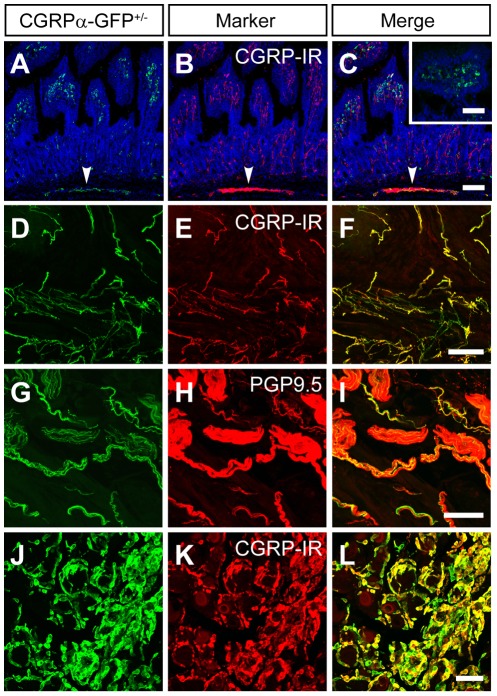
CGRPα-GFP axons and cells in visceral tissues.Sections of (A–C) small intestine, (D–I), bladder and (J–L) thyroid from CGRPα-GFP+/− mice were stained with antibodies to GFP (A, D, G, J) and the indicated markers. Nuclei in (A–C) were labeled with DRAQ5. (C-inset) Section of wild-type mouse small intestine stained for GFP (green) and DRAQ5 (blue). Images were acquired by confocal microscopy and are representative of n = 3 mice. Scale bars in (C) and (C-inset) inset are 100 µm and apply to (A–C). Scale bar in (L) is 50 µm and applies to (D–L).